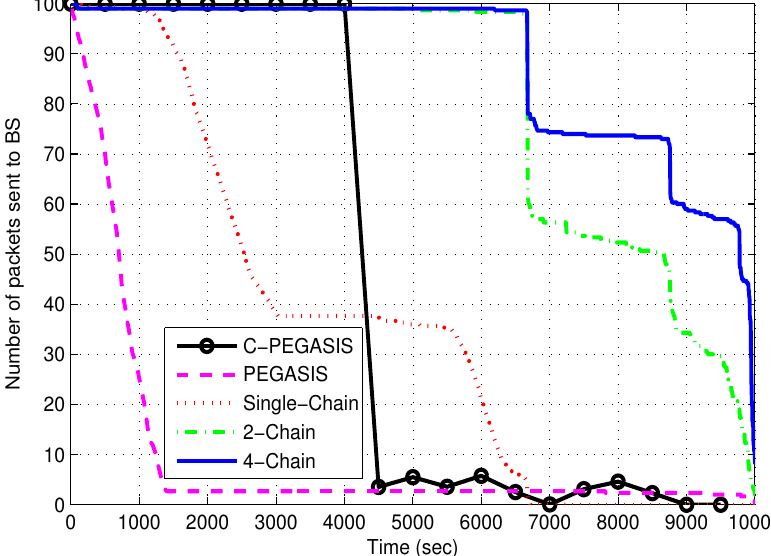
Figure 12. Network throughput in 4-chains, 2-chains, single-chain based routing and